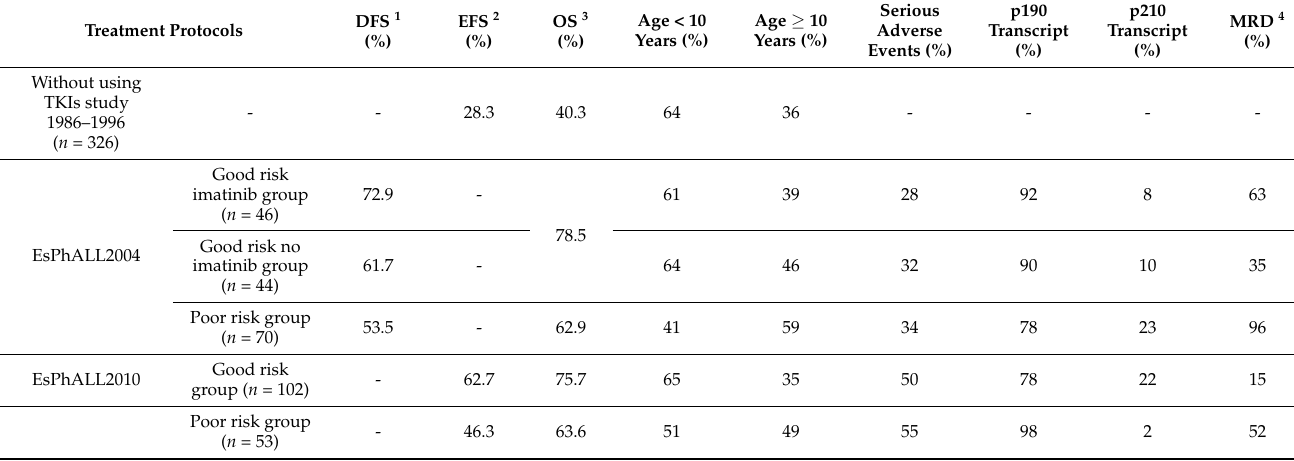
Table 1. Comparison of treatment results without the use of TKIs, and the EsPhALL 2004 and 2010 protocols. Treatment